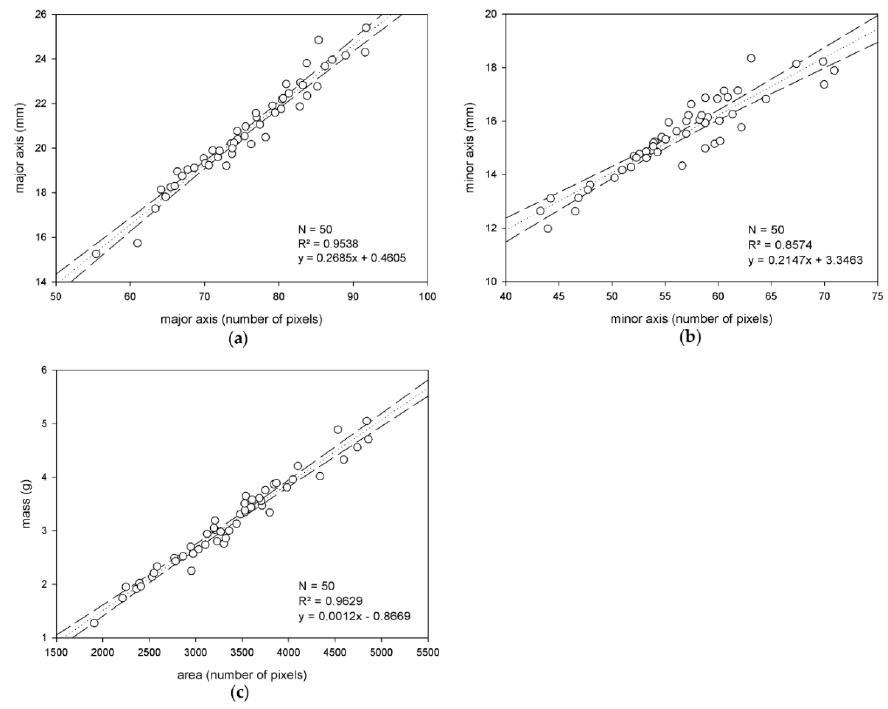
Figure 6. Correlation study performed for the Picual variety, considering the three different sizing features of the fruits the experiment is focused on: The major axis ( a ), minor axis ( b ) and mass ( c ).